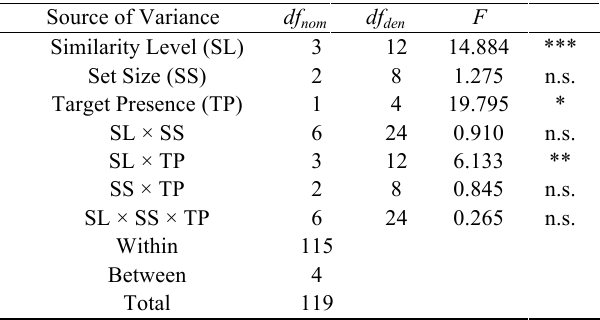
Three-way repeated measures analysis of variance for error rates.